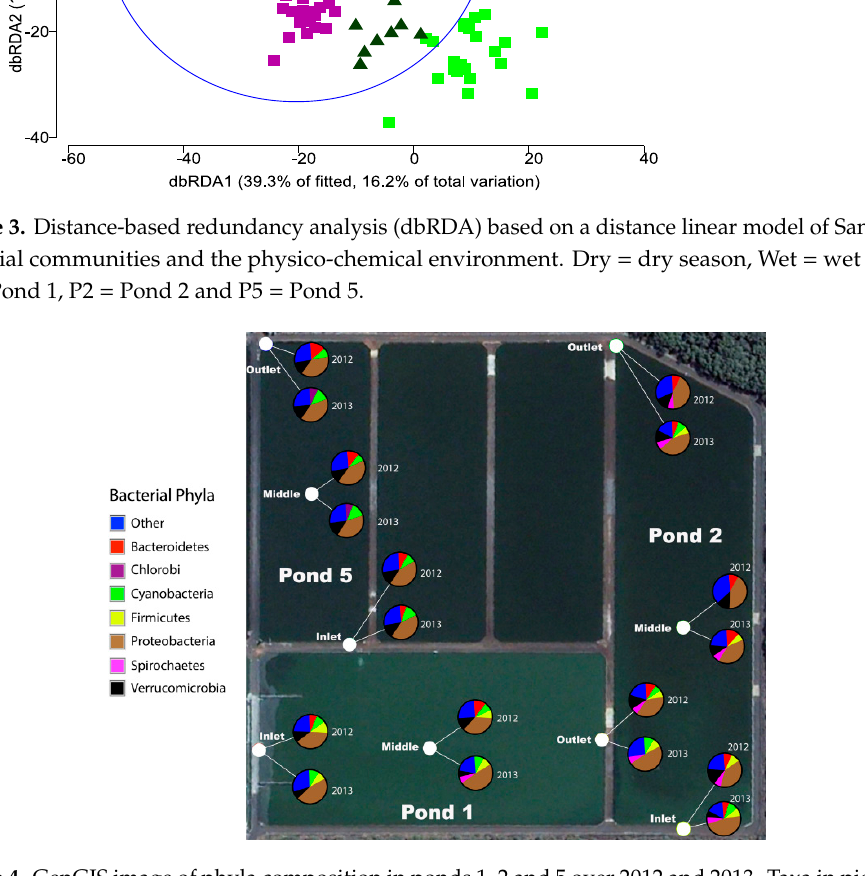
Figure 4. GenGIS image of phyla composition in ponds 1, 2 and 5 over 2012 and 2013. Taxa in pie-charts represent those bacteria that contribute to >6% of the bacterial population. Number of samples per pie chart = 16.